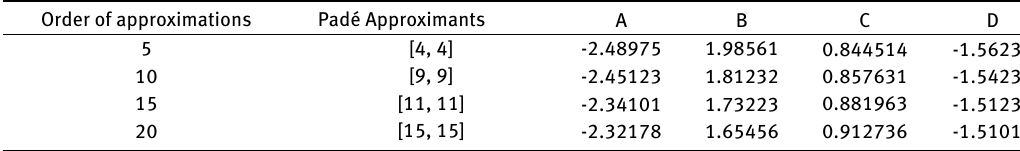
Table 2: The values of A, B and C in case when β 1 = 0.1, β 2 = 0.1, Pr = 1, N t = N b = 0.1, Le = 0.2, λ = 1.